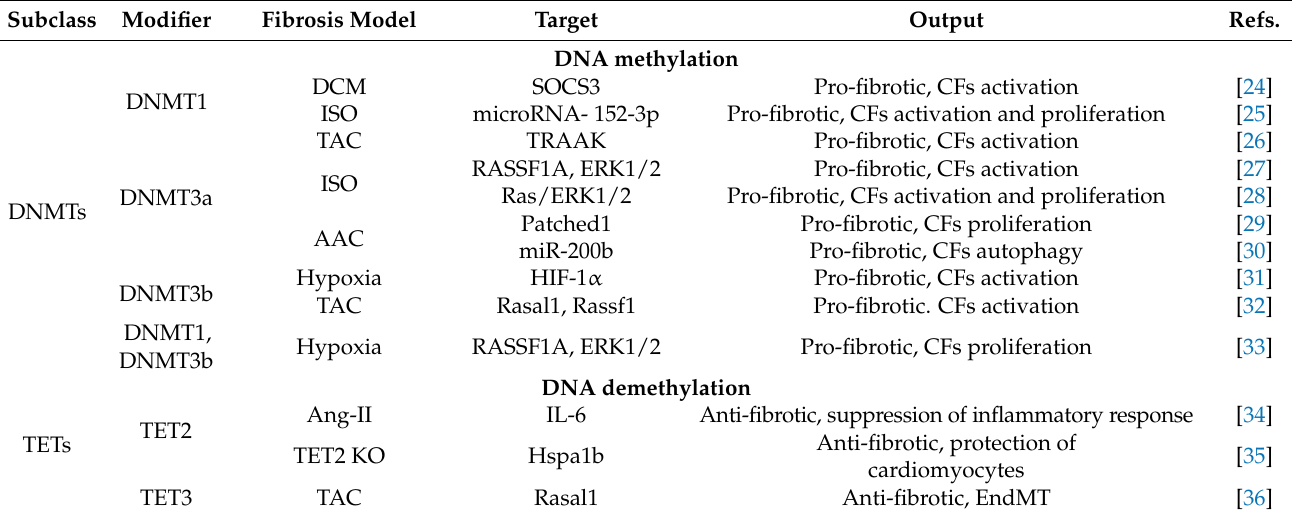
Table 1. The roles of DNA methylation modifiers in CFs activation and cardiac